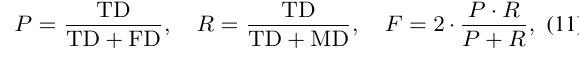
Table 1: Quantitative results on different databases. The performance of SIFT-graph (Sirmac¸ek and ¨Unsalan, 2009), Gabor features (Sirmac¸ek and ¨Unsalan, 2011), bMBD (Benedek et al., 2012) and the proposed multidirectional (MultiDir) methods are compared. Nr. of buildings indicates the number of completely visible, whole buildings in the image. FD and MD denote the number of False and Missed Detections (false positives and false negatives). Best results in every row are marked in